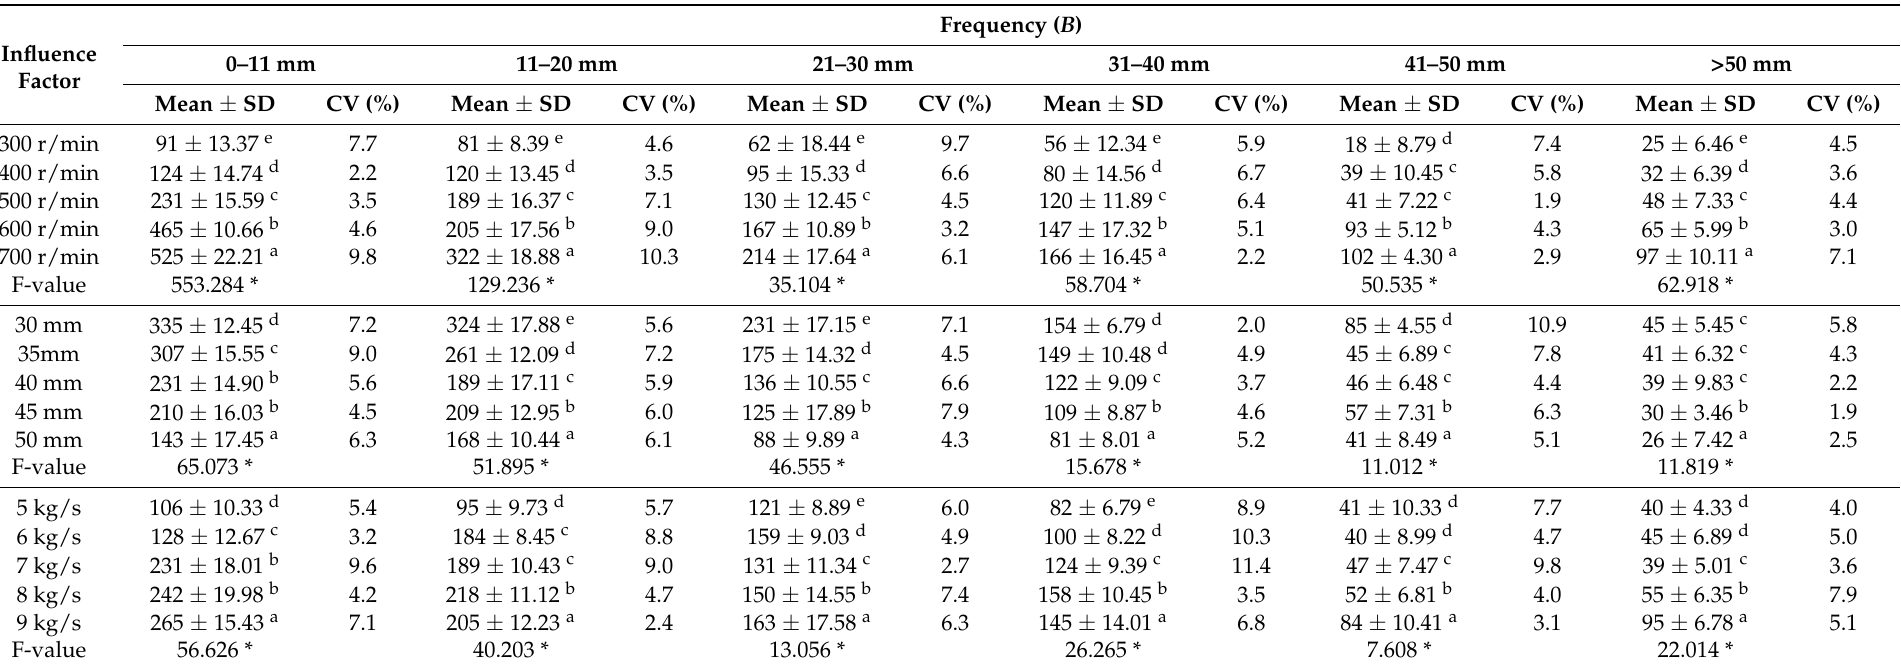
Table 5. Effect of process parameters on Frequency ( B ) of corn husks and repeated measures analysis of